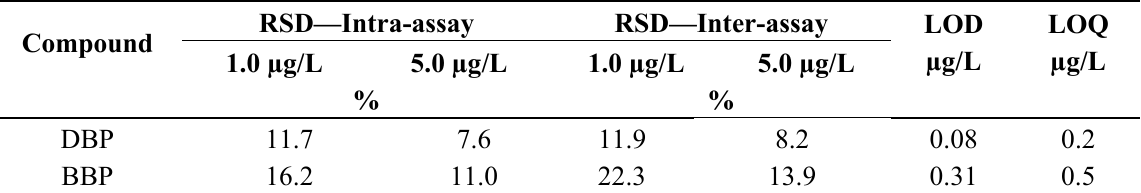
Table 3. Precision, limits of detection, and quantification of DBP and BBP (n = 10).